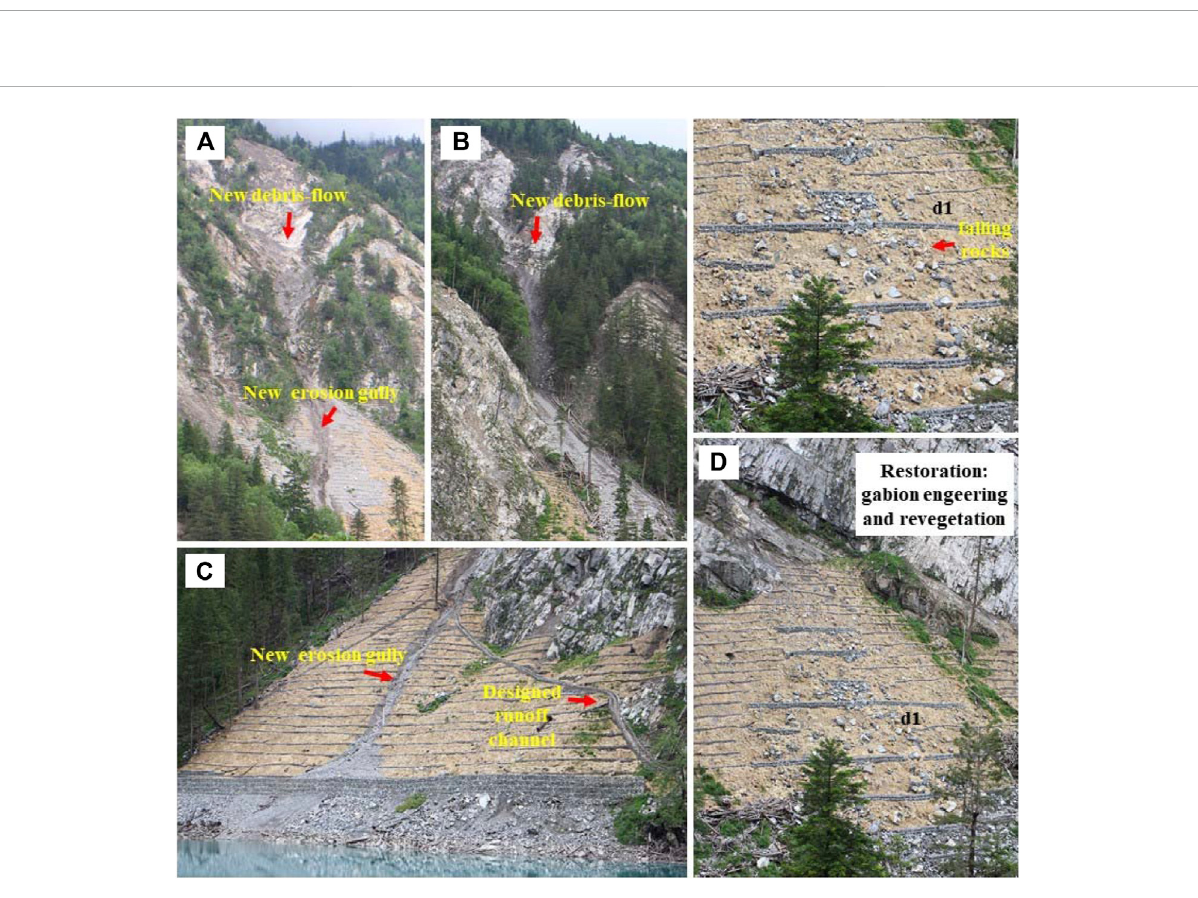
FIGURE 5 Unpredicted problems occurring after ecological restoration projects at Panda Lake. Note: the photographs in panels (A-C) show new debris- fl ow and new erosion gully; the photographs in panel (D) show falling rocks in the revegetated area; all photographs were taken in June